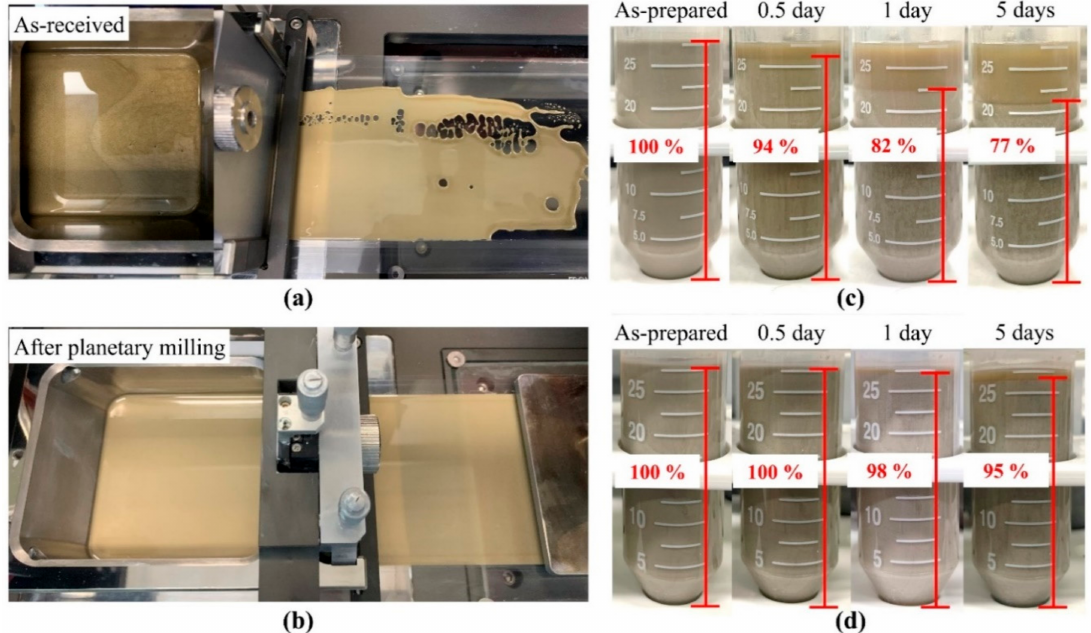
Figure 3. State of the ( a ) as-received mica slurry and ( b ) planetary milled mica slurry after passing through the doctor blade. Sedimentation of the ( c ) as-received and ( d ) planetary milled mica slurries (solid loading = 40